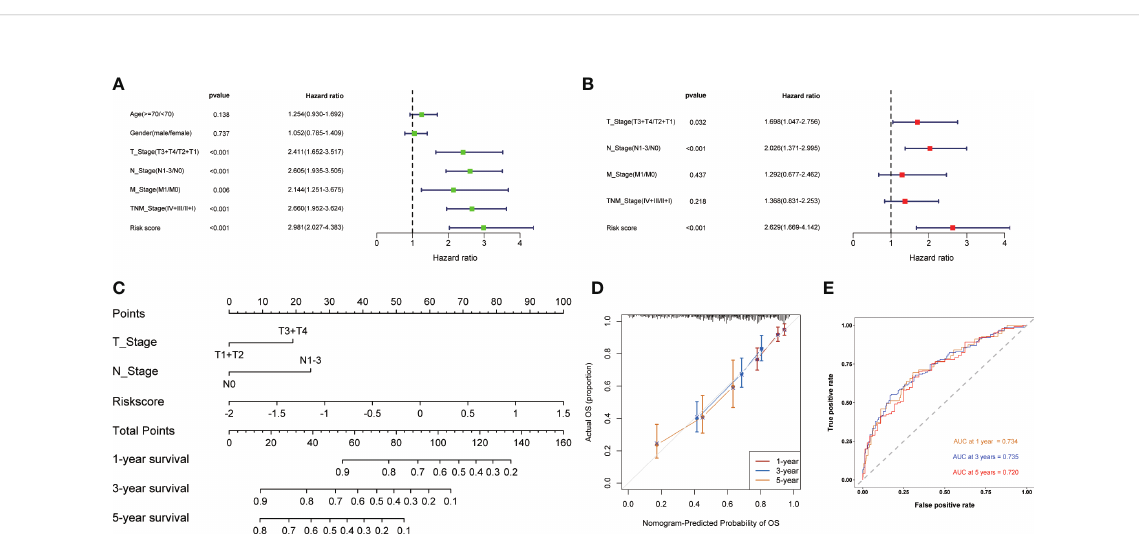
FIGURE 4 Construction of the nomogram based on CMRGS in TCGA cohort. Univariate (A) and multivariate (B) analysis of based on risk score and clinical features. (C) Nomogram for the prediction of 1-, 3- and 5-year survival probability. (D) Calibration curves for evaluating the agreement in the predicted and actual OS. (E) Time-dependent ROC analysis of the